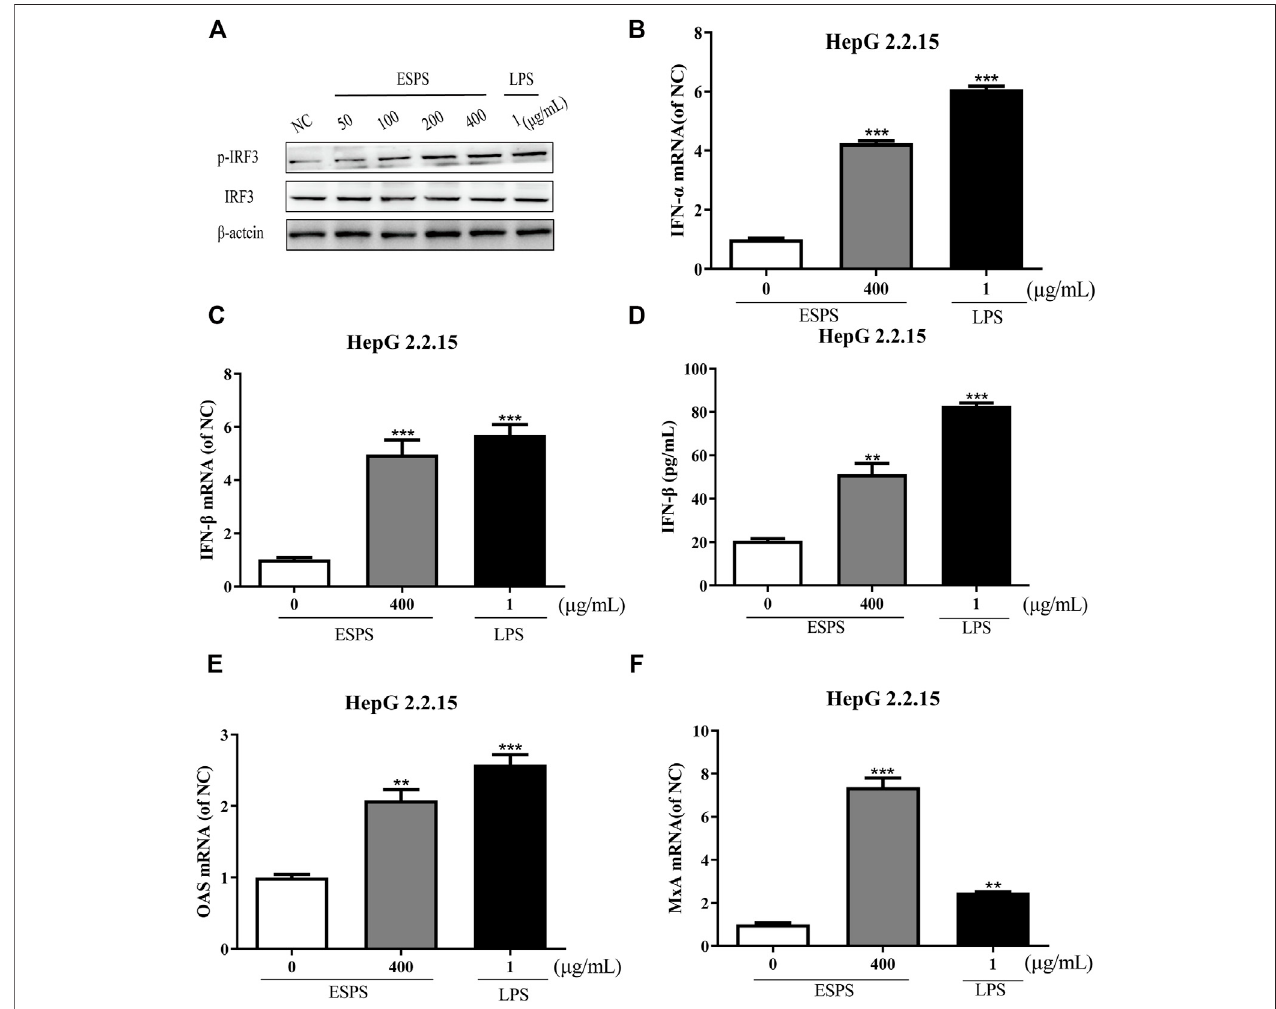
FIGURE 3 | Activation of interferon signaling pathway by ESPS in HepG2.2.15 cells. After treatment with ESPS at indicated concentrations, Western blotting analysiswasusedtodetectthelevelsofIRF3orp-IRF3 protein; β -actin proteinwasusedasloadingcontrol (A) .qPCRwasused todetectthelevelsofintracellular IFN- α (B) , IFN- β (C) , OAS (E) , and MxA (F) . Secreted IFN- β (D) was detected by ELISA. LPS was used as positive control. Values are means ±SD ( n = 3). ** p < 0.01, *** p < 0.001 vs . the normal control